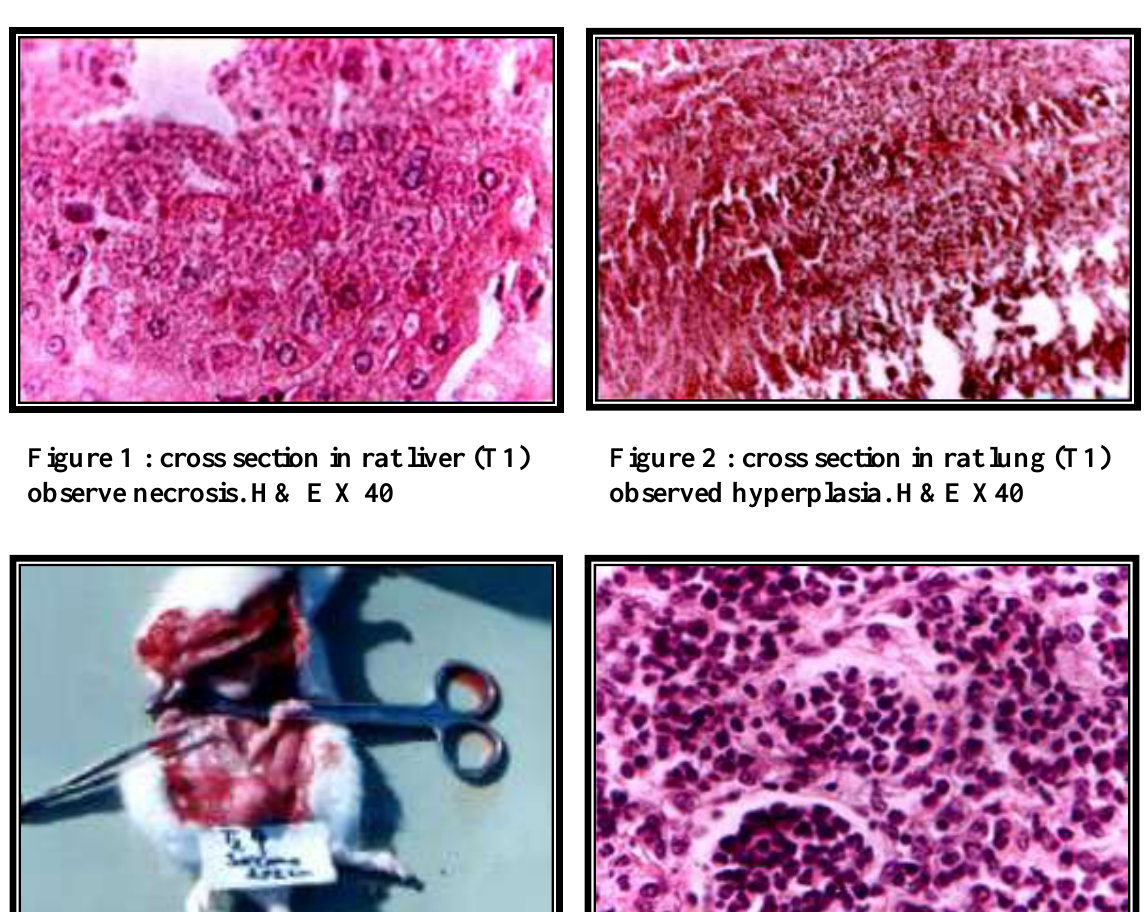
Figure 4 : cross section of fibroma in rat (T2) H&EX40